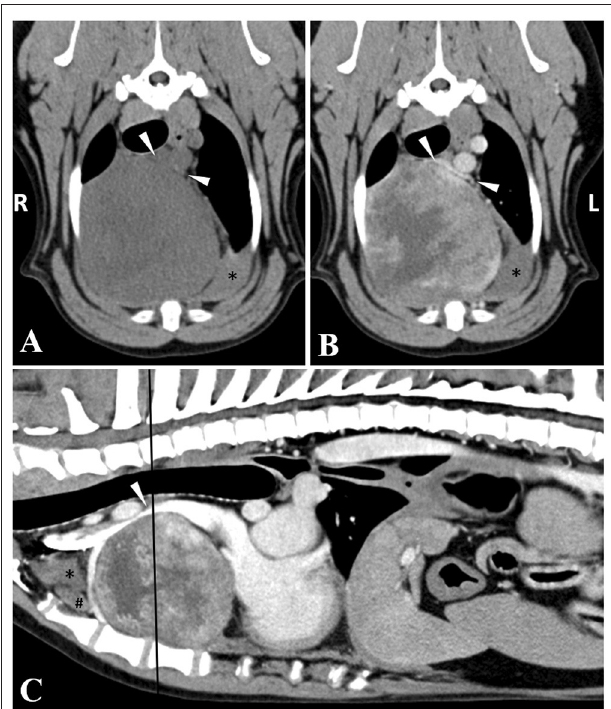
FIGURE 1 | Transverse (A,B) and sagittal (C) plane CT images of the cranial mediastinal mass with a black line representing the location on the sagittal image. The cranial vena cava (arrowheads) is compressed ventrodorsally by the large mediastinal mass, being bordered dorsally by the brachiocephalic trunk. The mass is soft tissue attenuating, with heterogeneous contrast enhancement, and a well-defined margin. Note the pleural (*) and mediastinal (#) fluid that is not contrast enhancing. Window width and window level were adjusted to 300/40 (soft tissue window), the slice thickness was 2mm, and the image was acquired with 120